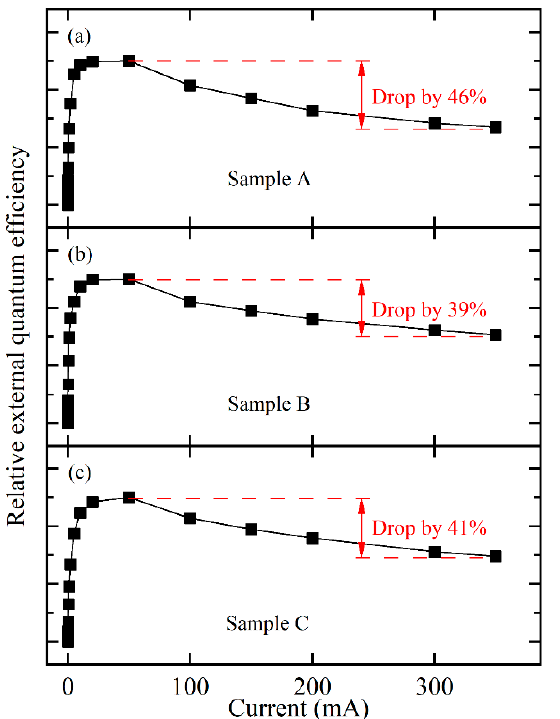
Figure 7. Relative efficiency of sample A ( a ), sample B ( b ), and sample C ( c ) as a function of injection current at 300 K.